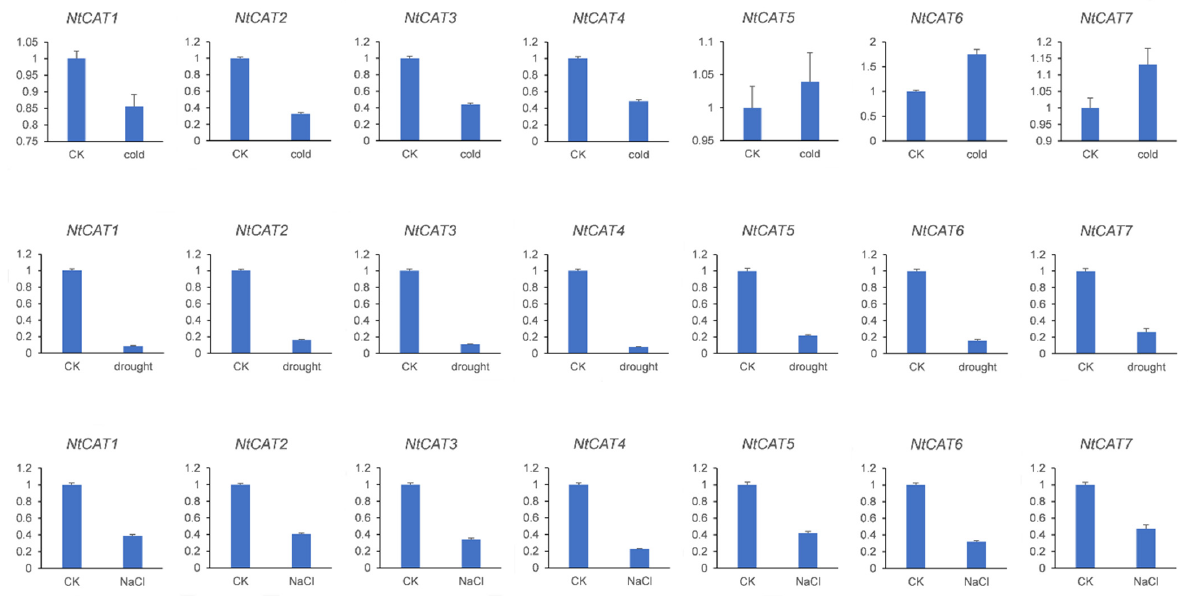
Figure 4. Expression patterns of NtCATs in response to cold, drought and NaCl treatments.